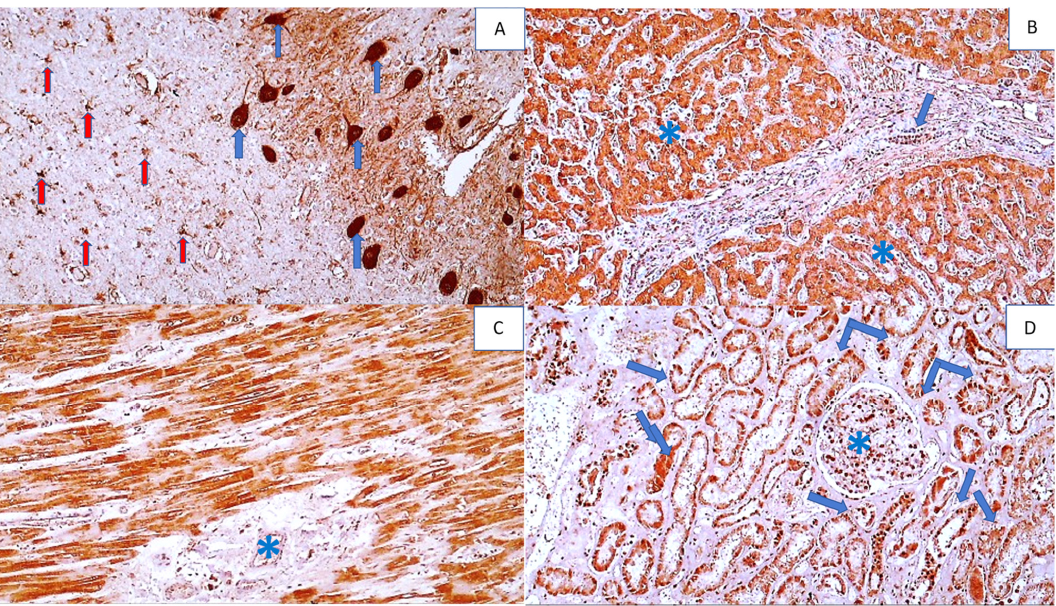
Figure 11. Immunohistochemistry for SOD2 adducts in the vital organs of a COVID-19 patient (except the lungs). Photo ( A ) shows strong immunohistochemical positivity for SOD2 in neurons (blue arrows) and reactive astrocytes (red arrows) in brain tissue (DAB, 400 × ). Photo ( B ) shows strong immunohistochemical SOD2 positivity in hepatocytes (asterisks) and bile duct epithelium (arrow) (DAB, 200 × ). Photo ( C ) shows strong SOD2 positivity in myocardial muscle fibers, but not in the endomysium (asterisk) (DAB, 200 × ), while Photo ( D ) shows SOD2 positivity in renal tubules (arrows) and glomerulus (asterisk) (DAB, 200 ×